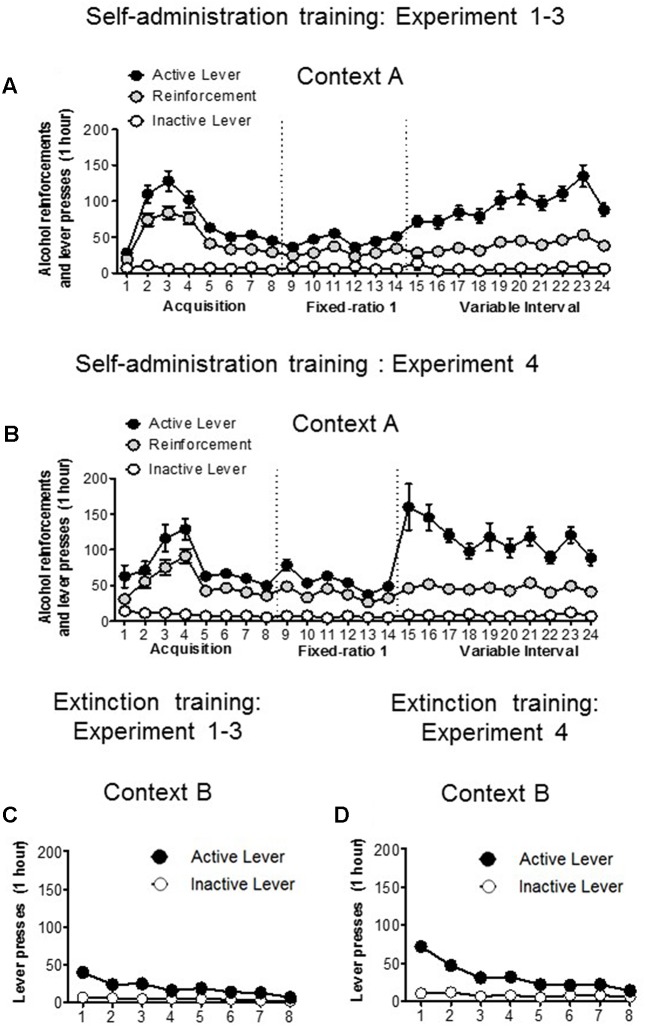
Training and extinction of ethanol reinforcement responding. (A,B) Rats were trained to self-administer ethanol over 24 days. Data depict the mean (±standard error of the mean [SEM]) number of infusions, and active and inactive lever presses during ethanol self-administration training in context A in Experiments 1–3 (n = 34) and experiment 4 (n = 31). (C,D) Mean (±SEM) number of presses on the active lever and inactive lever during eight extinction sessions conducted in context B in Experiments 1–4.